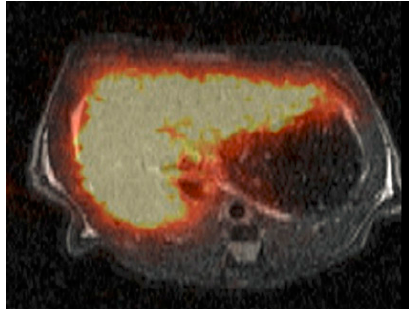
Figure 7. Accumulation of 68 Ga-NOTA-GSA in rat liver 30 min p.i. [215].